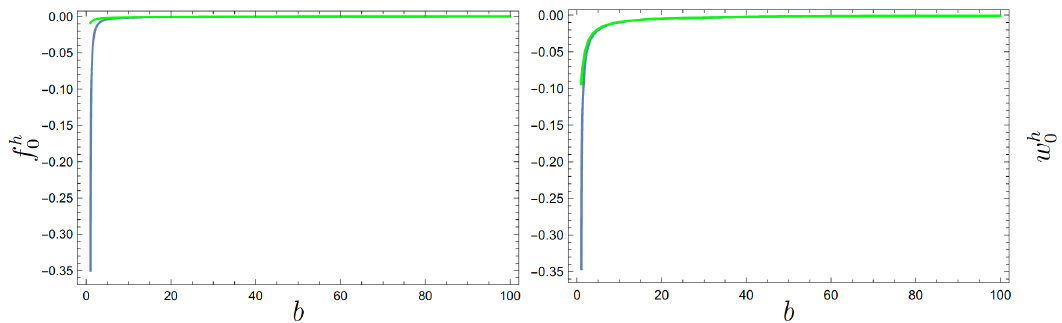
Figure 7 . Conformal order in the deformed Model III arises due to negative values (3.56) of f and w scalars at the Schwarzschild horizon (blue curves), resulting in the effective mass of λ -scalar, see (3.61), below the effective BF bound. The green curves represent large- b approximations to { f h , w h } , see (3.60). 0 0